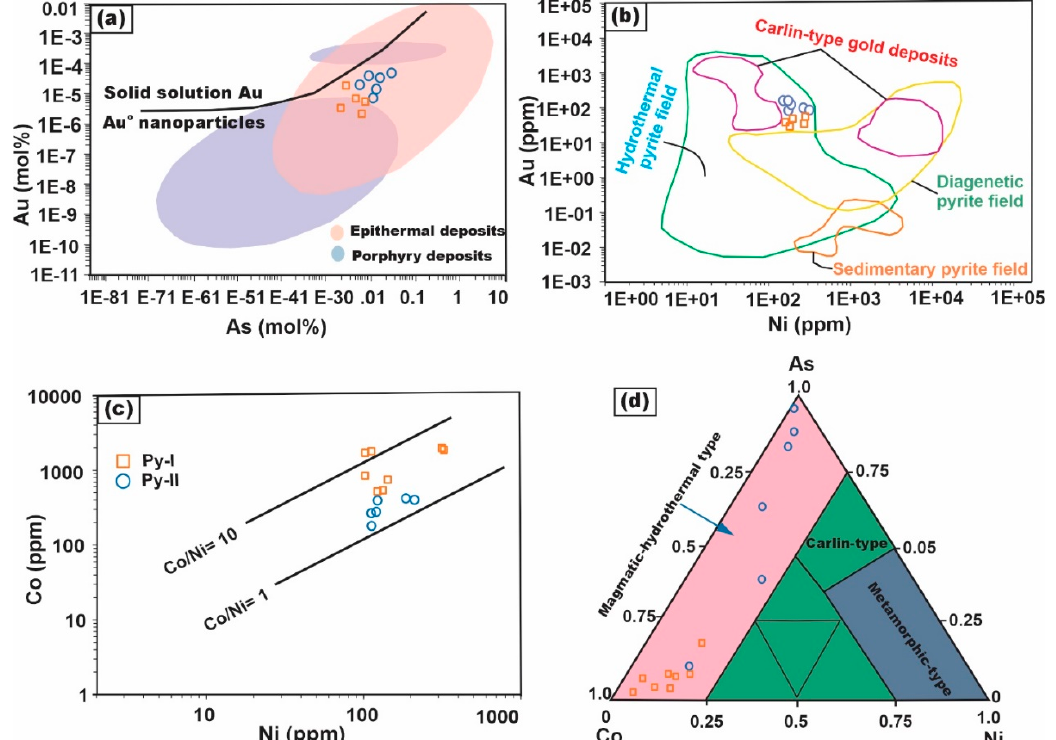
Figure 14. Pyrite mineralization plots: ( a ) Au-As plot, dash line showing Au solubility limit, (after [45,63]); ( b ) Au-Ni plot of Py-I and Py-II fall in the hydrothermal field, (after [95]); ( c ) Co and Ni ratio > 1 suggesting hydrothermal origin for the studied ores, (after [96]); ( d ) Co-As-Ni ternary diagram of the Kargah Cu-Pb deposit indicating magmatic-hydrothermal origin, (after [44,85]).